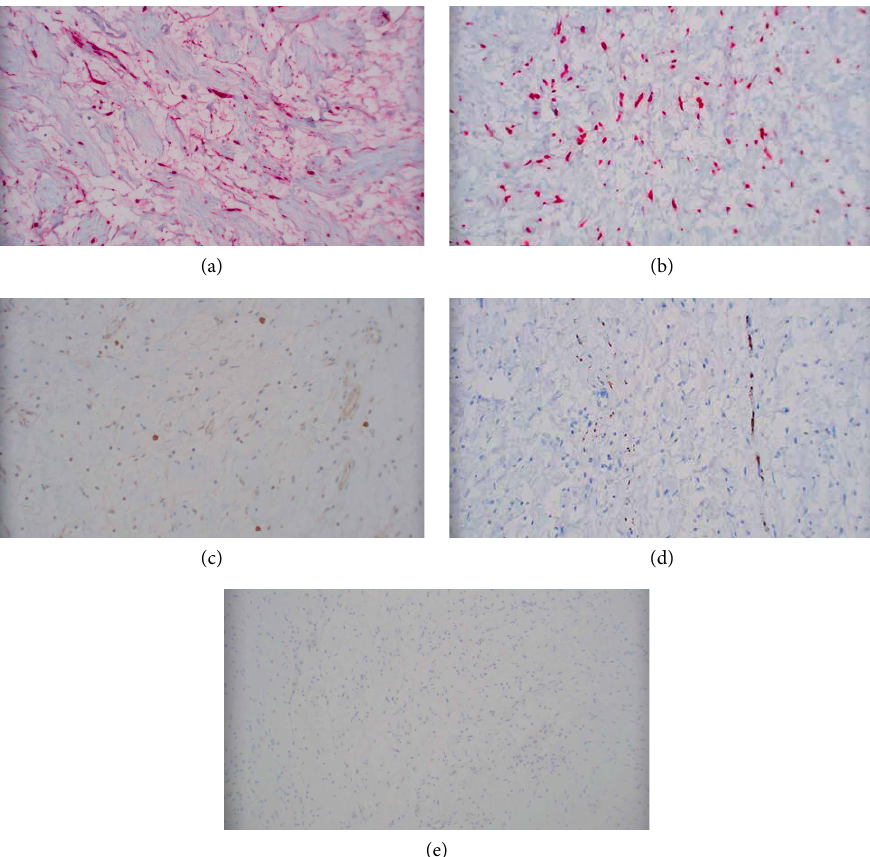
Figure 4: (a) Tumor cells diffusely positive for S100 protein (200x). (b) Tumor cells showing SOX-10 positivity (200x). (c) CD117 highlighting mast cells (200x). (d) Neurofilament highlighting the trapped axons (200x). (e) Tumor cells negative for STAT6